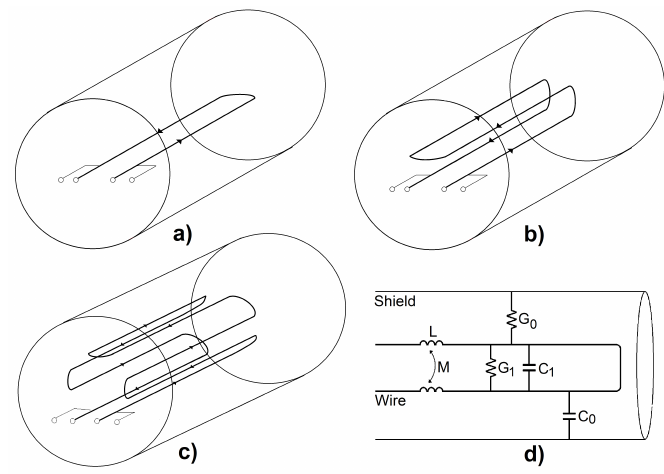
Figure 2. Types of calculable resistor geometries. ( a ) Bifilar geometry; ( b ) Quadrifilar geometry; ( c ) Octofilar geometry; ( d ) Parasitic impedance in a bifilar